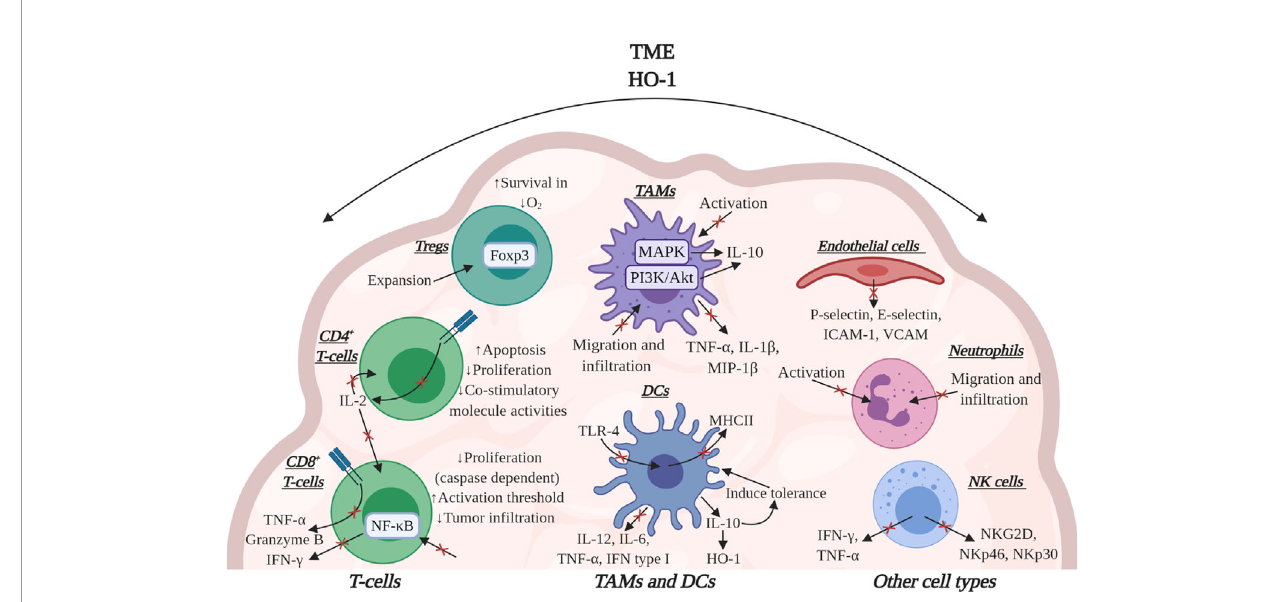
FIGURE 4 | The effects of HO-1 activity on immune cells in the TME. HO-1 activity may affect several immune cell types to suppress the anti-tumor immune response. HO-1 reduces the effector functions of CD8 + T-cells by suppressing their expression of TNF- a , granzyme-B and IFN- g . Speci fi cally, CO suppresses the effector functions mediated via TCR engagement. HO-1 has also been implicated in suppressing CD8 + T-cell proliferation, tumor in fi ltration and increasing their activation threshold. In CD4 + T-cells CO can block TCR-dependent IL-2 production, thus in fl uencing the proliferation of CD8 + and CD4 + T-cells. Bilirubin/Biliverdin can block CD4 + T-cell activity by inducing apoptosis, inhibiting proliferation and suppressing co-stimulatory molecule activities. In Tregs, HO-1 has been associated with the expansion of the population and HO-1-derived CO can improve Treg survival in conditions of hypoxia. HO-1 can also cause DCs to secrete IL-10 which maintains these cells in a tolerogenic state alongside up-regulating their expression of HO-1. HO-1 activity also down-regulates the expression of pro-in fl ammatory cytokines in these cells. Additionally, both CO and bilirubin can down-regulate MHCII expression in DCs. In TAMs, CO inhibits activation while also suppressing the release of pro-in fl ammatory cytokines and concurrently eliciting an increase in IL-10 production. In endothelial cells, CO can suppress the expression of adhesion molecules, affecting the ability of neutrophils to attach. HO-1 may also inhibit neutrophil activation itself and CO and biliverdin can inhibit migration and in fi ltration of both neutrophils and TAMs. Additionally, in NK cells HO-1 activity can decrease their cytotoxicity by suppressing their ability to secrete pro-in fl ammatory cytokines and express activatory cell receptors. Image was created using BioRender